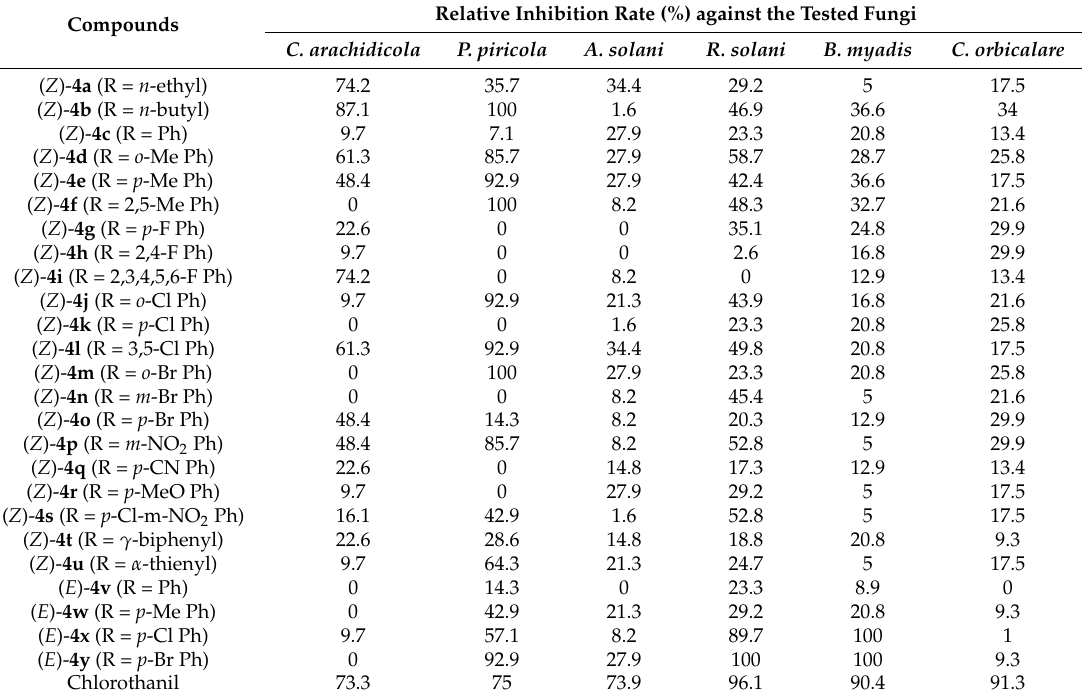
Table 1. Antifungal activity of the target compounds ( Z )- 4a – 4u and ( E )- 4v – 4y at 50 µ g/mL. Relative Inhibition Rate (%) against the Tested Compounds